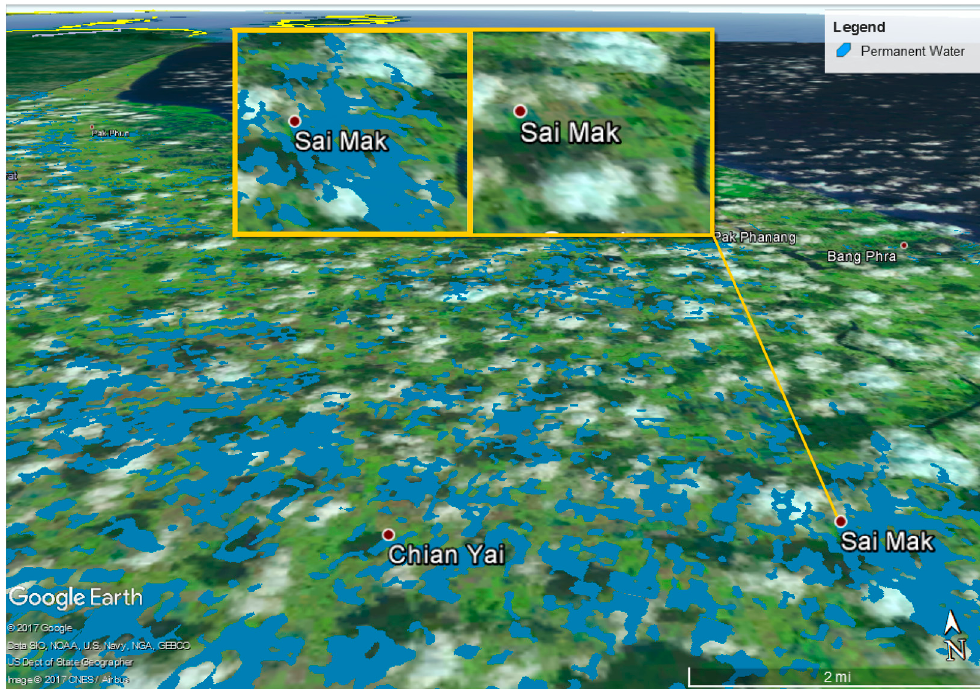
Figure 12. Discrimination between flooded areas in light blue (left inset) and the Sentinel-2 (right inset) image in Pak Phanang district, Nakhon Si Thammarat.